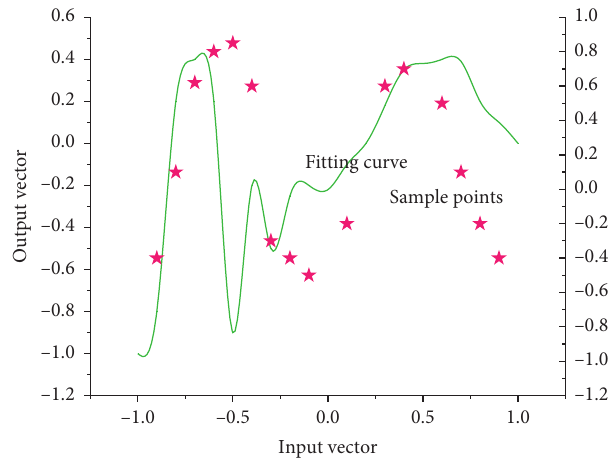
Figure 4: Network over adaptation.